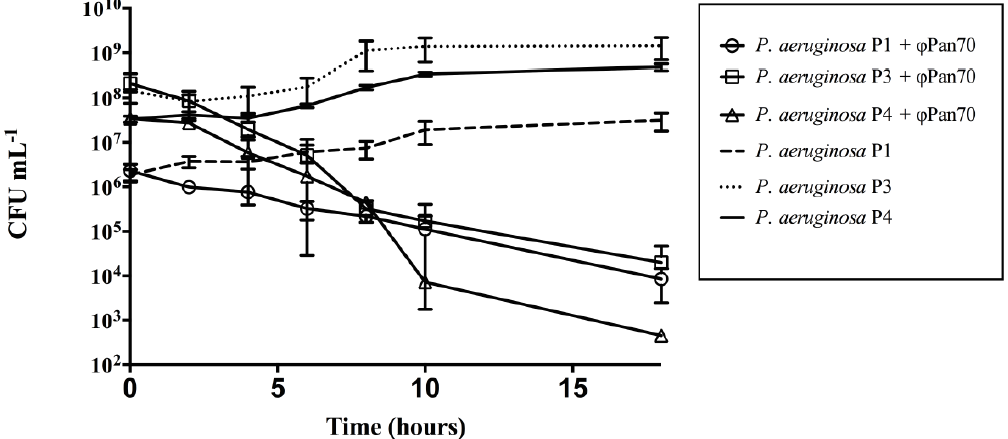
Figure 2. Bacteriophage ΦPan70 activity in planktonic cells of three different Multiple Drug Resistant bacteria (MDR) strains of Pseudomonas aeruginosa . Activity of ΦPan70 was assayed against planktonic cells of P. aeruginosa P1, P3 and P4. The corresponding control cultures for each strain (without phage) are also shown. Addition of the phage caused a reduction in the bacterial population, and the magnitude of this reduction depended on the particular strain. MOIs used varied depending on the strain (28, 1, and 2, respectively), according to a previous work on mathematical modeling for phage titer optimization [18]. Each treatment and control was performed in triplicate.